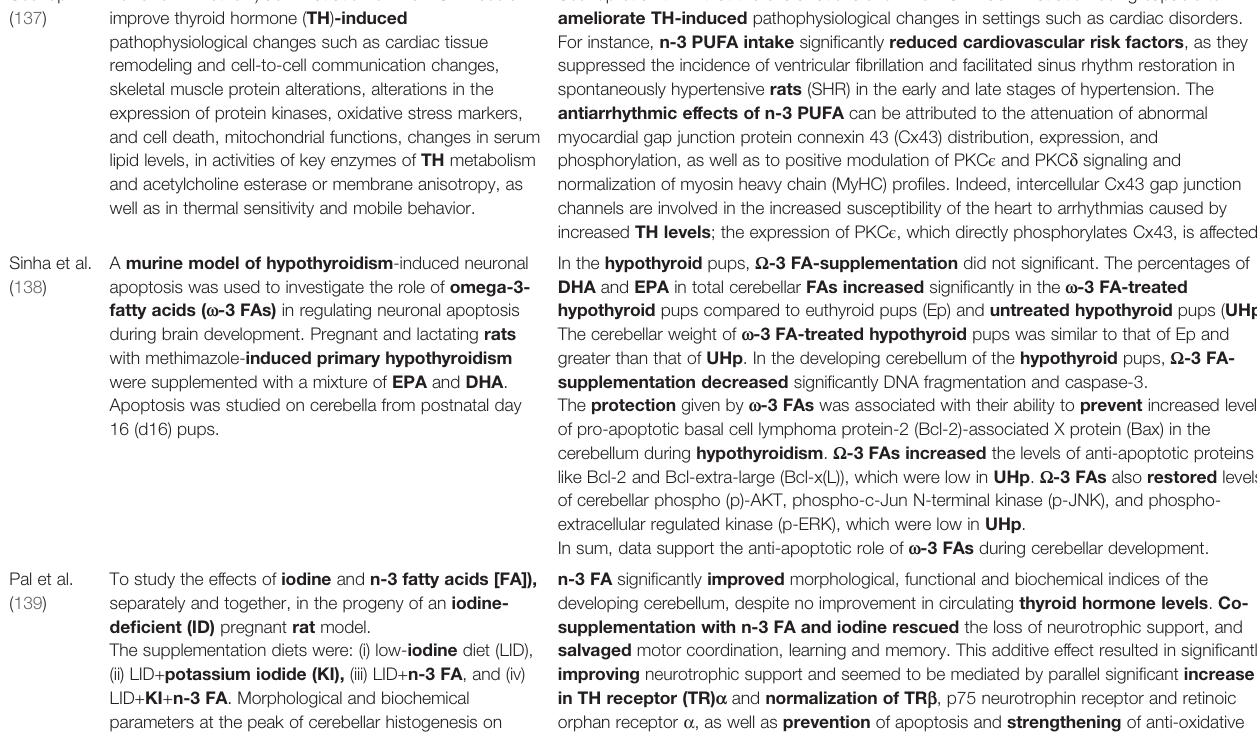
TABLE 5 | Studies in experimental animals on the effects of the omega-3 polyunsaturated fatty acids (PUFA) in the thyroid setting. * Reference Aims and animals studied Main fi ndings Soukup